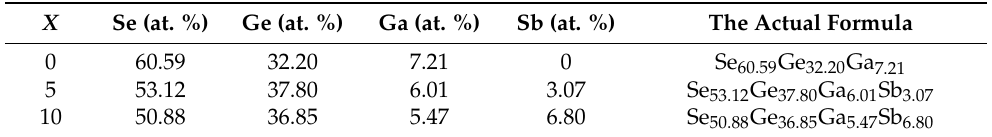
Table 1. The average at. % of the constituent elements obtained from EDX of the studied